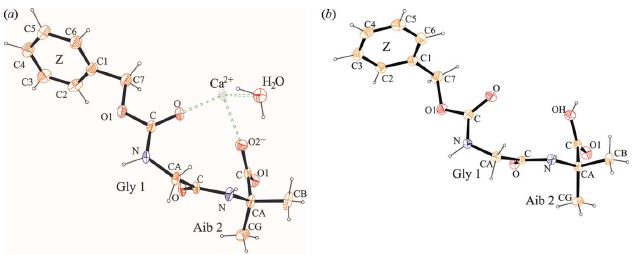
Figure 1 The molecular structures of Z –Gly–Aib–OH showing the 50% prob- ability displacement ellipsoids and simplified atom numbering (Farrugia, 2012). ( a ) The asymmetric unit of the complex with Ca 2+ and H 2 O (I). One metal ion is coordinated by two symmetry-inverted peptides and water molecules. ( b ) The structure of the neutral dipeptide Z -Gly-Aib- OH